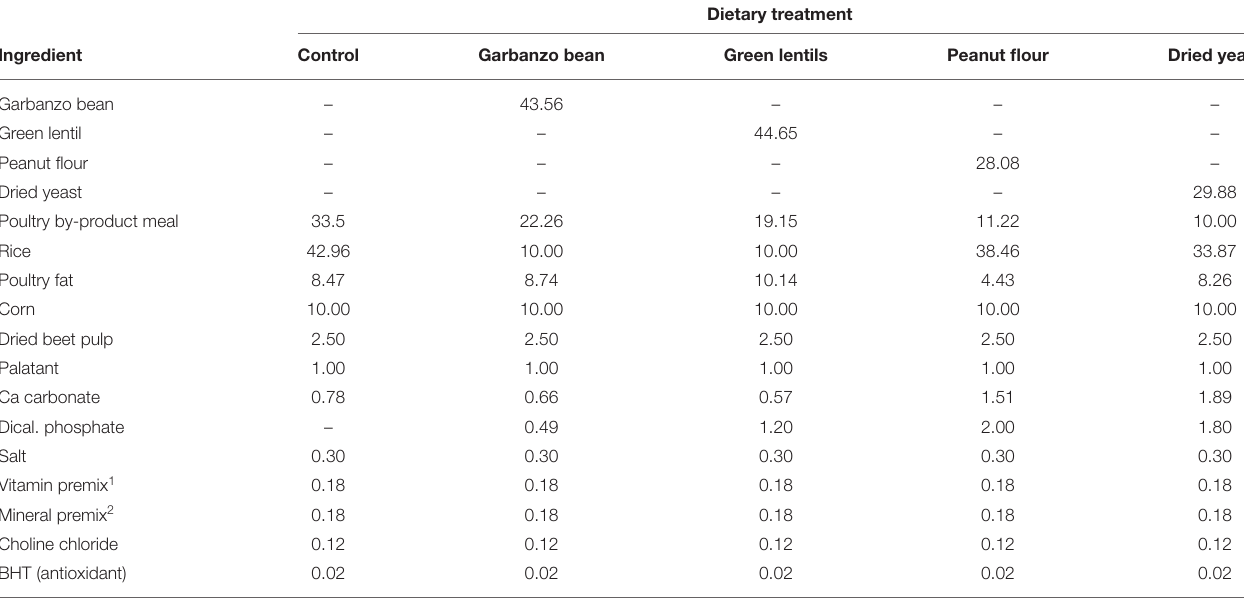
TABLE 1 | Ingredient composition of canine diets containing legumes or